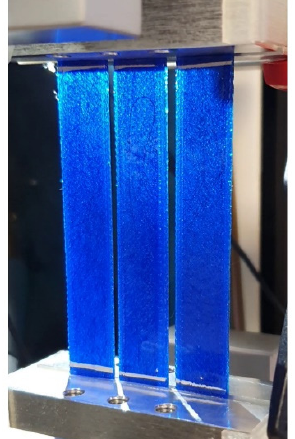
Figure 2. Clamped cyclic test samples in the ESM303 tensile tester. The samples were inspected with a background light, which revealed the integrated CFCs inside the 3D ‐ printed TPU matrix. a background light, which revealed the integrated CFCs inside the 3D-printed TPU